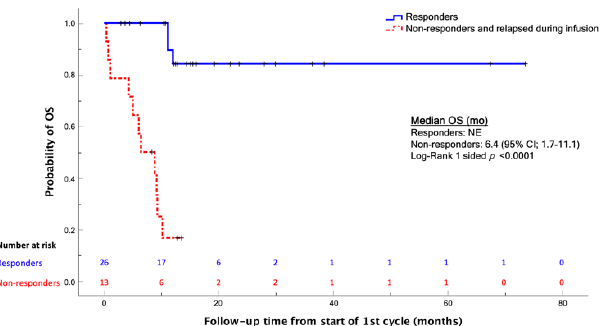
Figure 1. Kaplan-Meier analysis of the OS and EFS values in the cohort of patients between 2015 and 2020. ( a ) OS curve of the total cohort of 39 patients, median not evaluable over a mean follow- up of 16 months; ( b ) RFS curve of patients achieving remission, median 33.4 months; ( c ) OS and RFS curves of patients with <5% and ≥5% blasts at the time of blinatumomab administration. Abbrevia- tions: OS, overall survival; RFS, relapse-free survival; mo, months; NE, not evaluable.